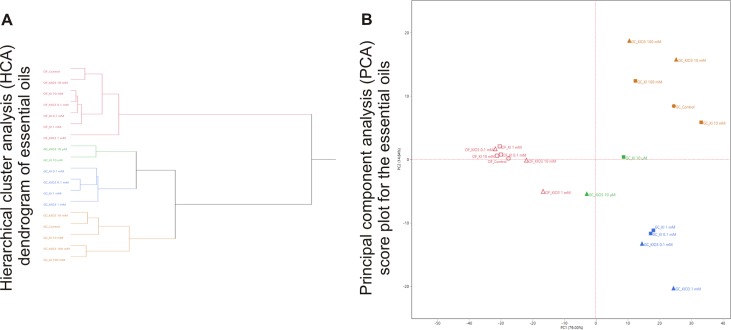
Multivariate statistical analysis on the essential oil compositions of all the samples.Hierarchical cluster analysis (HCA) dendrogram (A) and principal component analysis (PCA) score plot (B) for the complete compositions of leaf essential oils extracted from the open field and growth chamber samples.